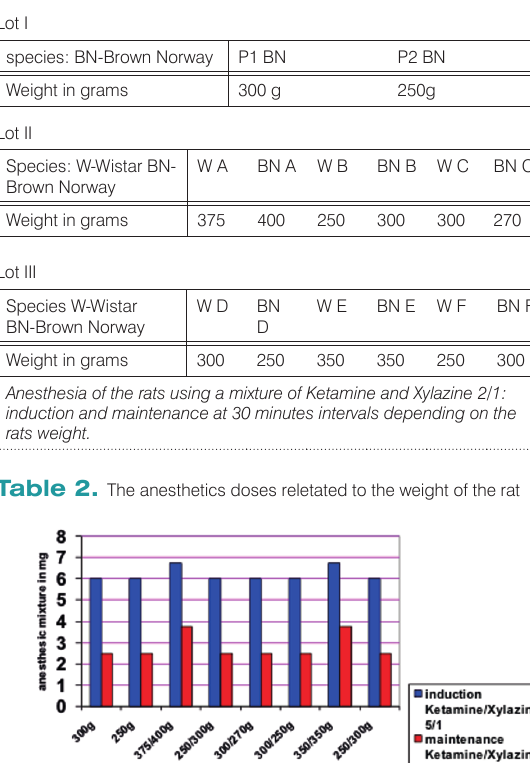
Table 1. Weights of the rats included in the study